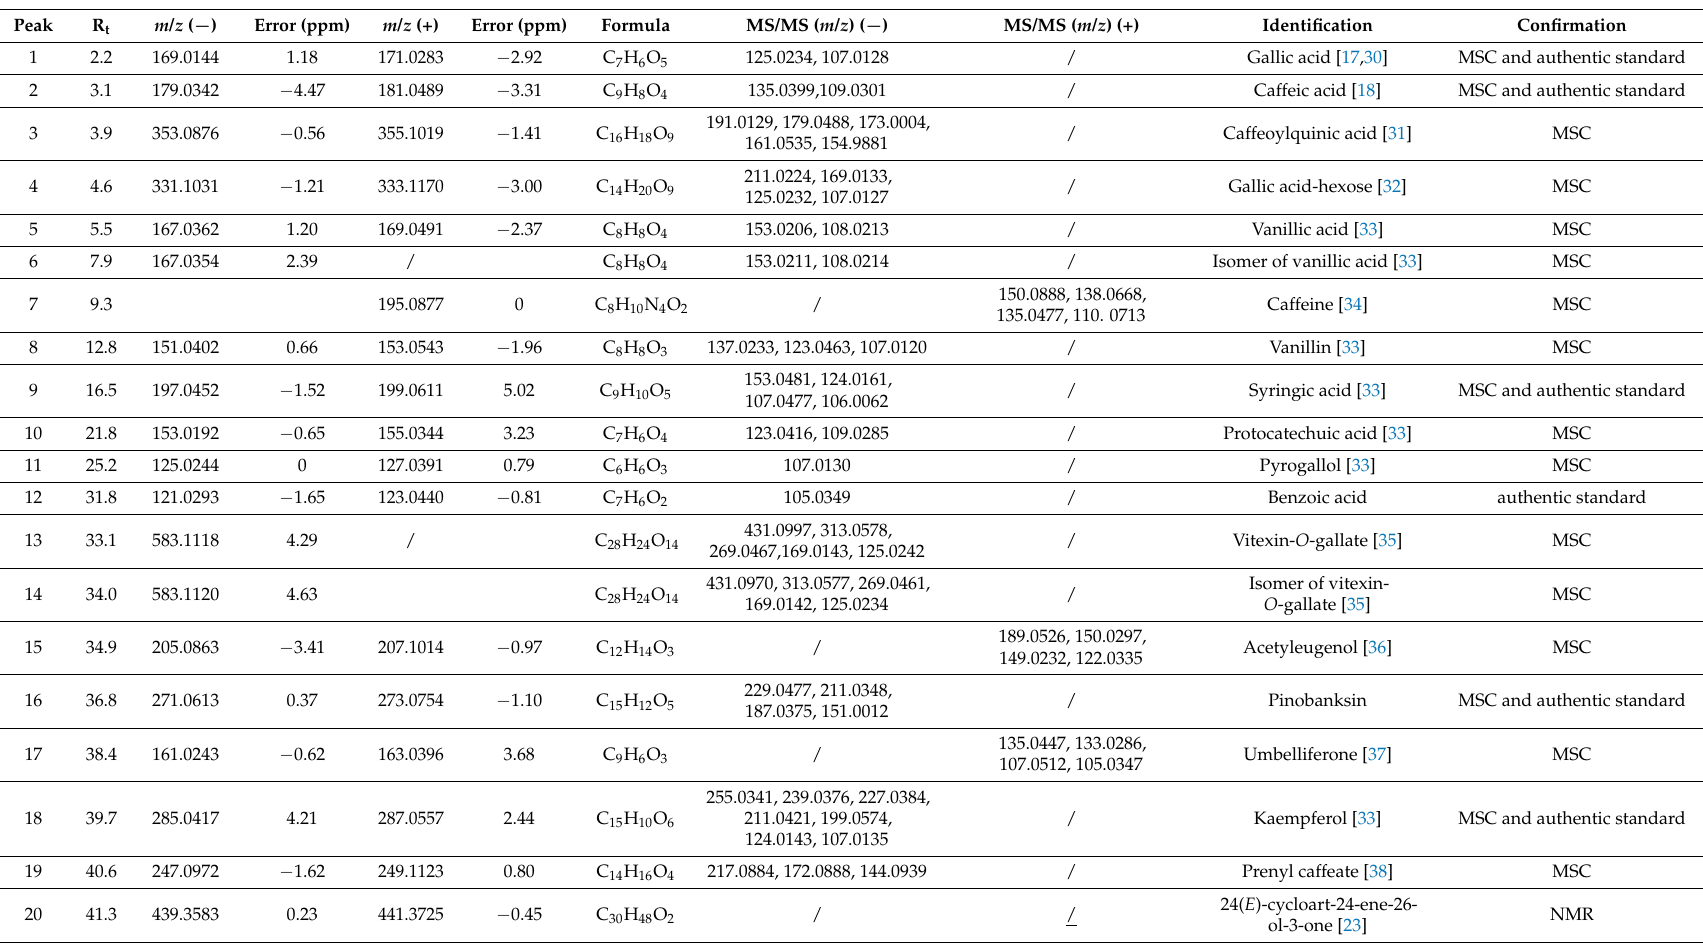
Table 1. Identification of compounds in the ethanolic extract of